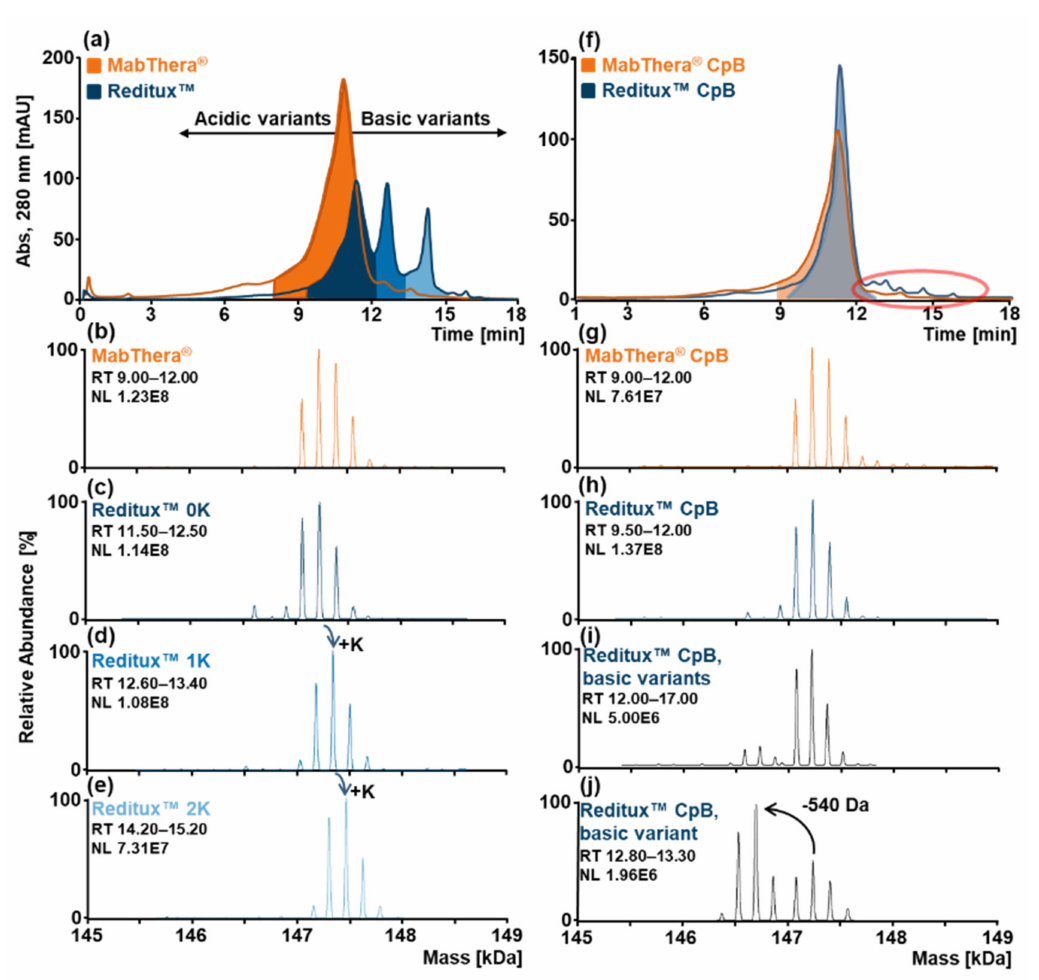
Figure 1. SCX-HPLC-MS analyses of MabThera ® (orange) and Reditux™ (blue). ( a ) SCX-HPLC-MS chromatogram of intact MabThera ® (orange) and Reditux™ (blue). Deconvoluted mass spectrum of ( b ) MabThera ® main variant without C-terminal lysine (0K), ( c ) Reditux™ variant without C-terminal lysine (0K), ( d ) Reditux™ variant with one C-terminal lysine (1K), ( e ) Reditux™ variant with two C-terminal lysine (2K). The three deconvoluted spectra of Reditux™ exhibit the same pattern shifted by +128 Da, corresponding to a lysine residue. ( f ) SCX-HPLC-MS chromatogram of MabThera ® (orange) and Reditux™ (blue) after treatment with carboxypeptidase B (CpB) to remove the C-terminal lysine. The red circle indicates basic variants that are present in Reditux™ and almost completely absent in MabThera ® . Deconvoluted mass spectrum of ( g ) MabThera ® main variant with complete clipping of C-terminal lysine (0K), ( h ) Reditux™ variant with complete clipping of C-terminal lysine (0K), ( i ) Reditux™ basic variants eluting at RT 12.00–17.00 min, ( j ) Reditux™ basic variant eluting at RT 12.80–13.30 min. Annotations of the spectra are reported in Tables